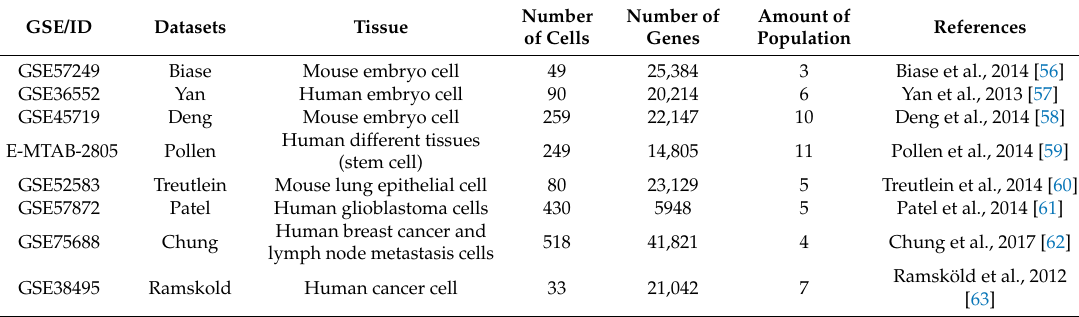
Table 1. List of datasets and their